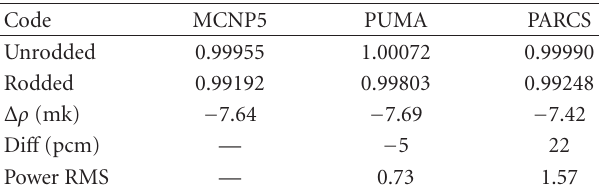
Figure 7: Control rod illustration (Cartesian). Table 9: CNA-II idealized core—nominal rod insertion.